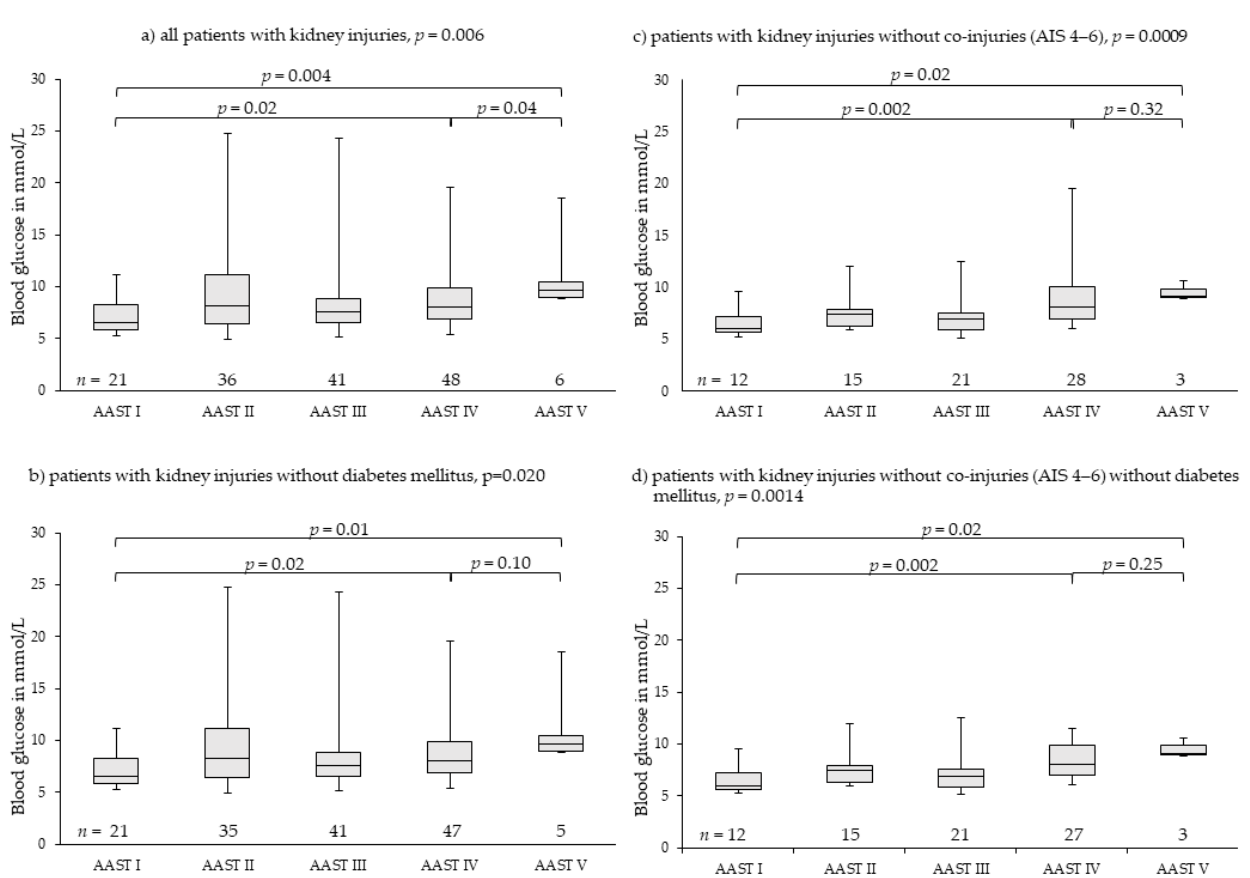
Figure 4. Rising blood glucose levels parallel to injury severity in renal injuries. Outliers of very high blood glucose levels in less severe injuries (AAST I-III) were found in patients with diabetes mellitus disease or severe co-injuries ( AIS 4–6 ) ( a – c ). In patients without severe co-injuries and without diabetes mellitus ( d ), the effect of injury severity and hemorrhage on blood glucose levels was demonstrated more clearly, meaning the greater the severity of injury and the hemorrhage extent, the higher the stress hyperglycemia including most severe renal injuries (AAST V). AAST: American Association for the Surgery of Trauma [27,28]; AIS: Abbreviated Injury Scale [43].